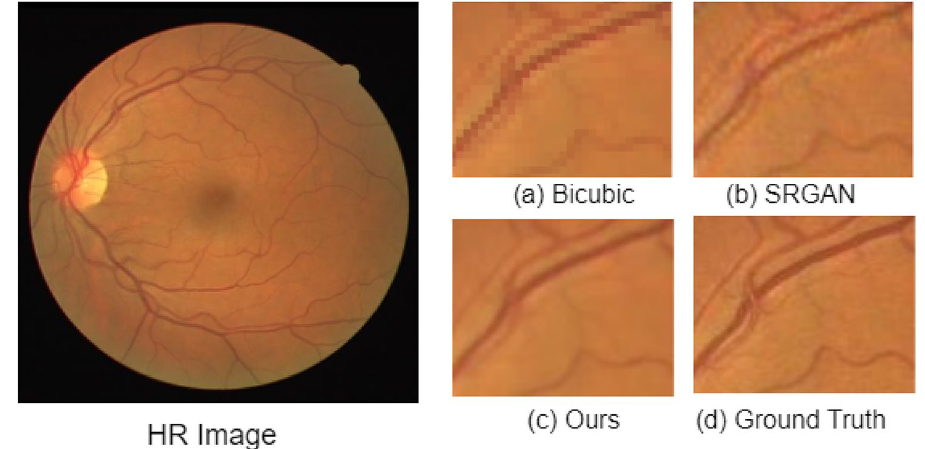
Figure 7. Small region results for an image from DRIVE dataset. The sub-region for ( a ) Bicubic interpolation. ( b ) SRGAN 31 . ( c ) Proposed architecture. ( d ) Ground truth HR image.